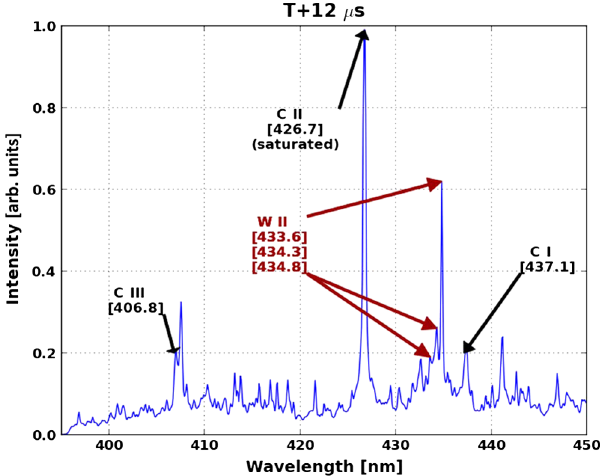
FIG. 8. Time-integrated spectra of the cusp plasma between 12 and 20 μ s after the plasma